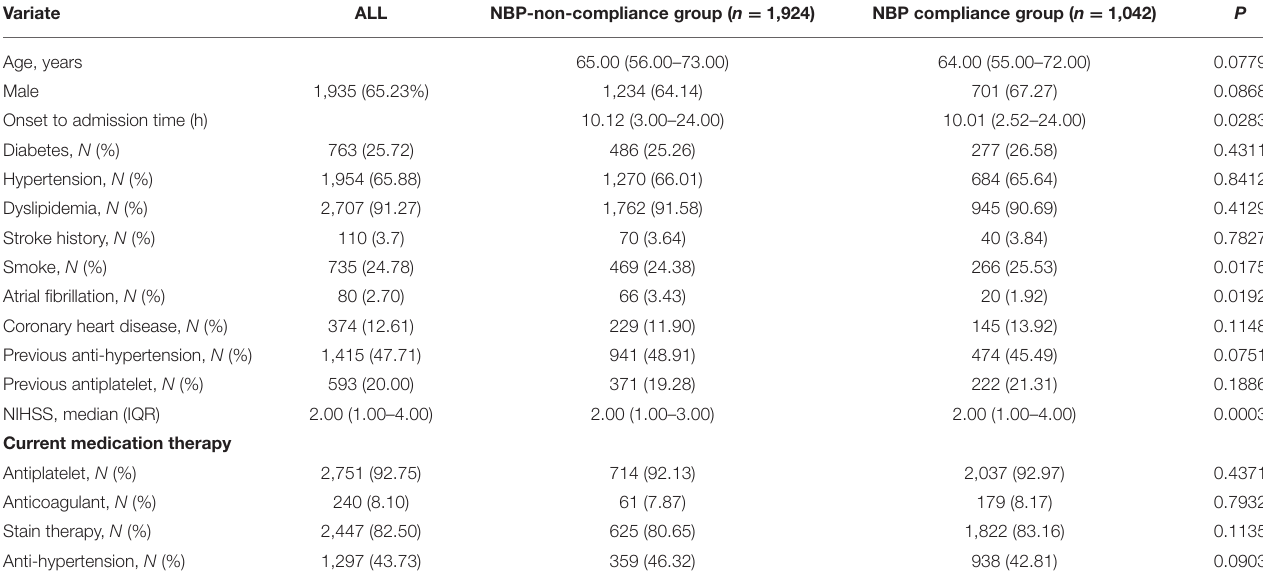
TABLE 1 | Baseline characteristics between NBP compliance and NBP-non-compliance